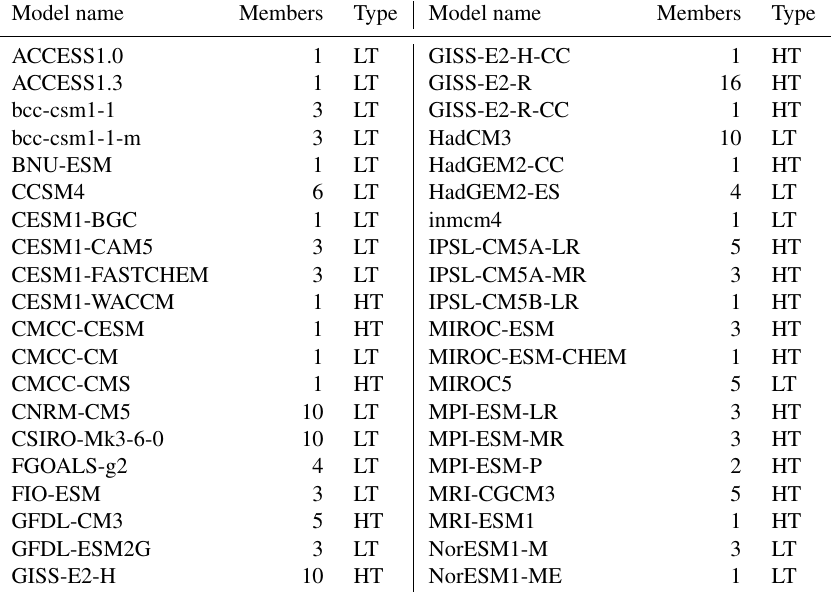
Table 1. Acronym, number of simulations, and high-top/low-top classification (based on Rea et al., 2018) for the historical integrations of the CMIP5 models analyzed in this paper. Information on model forcings and experimental design can be found in Taylor et al.